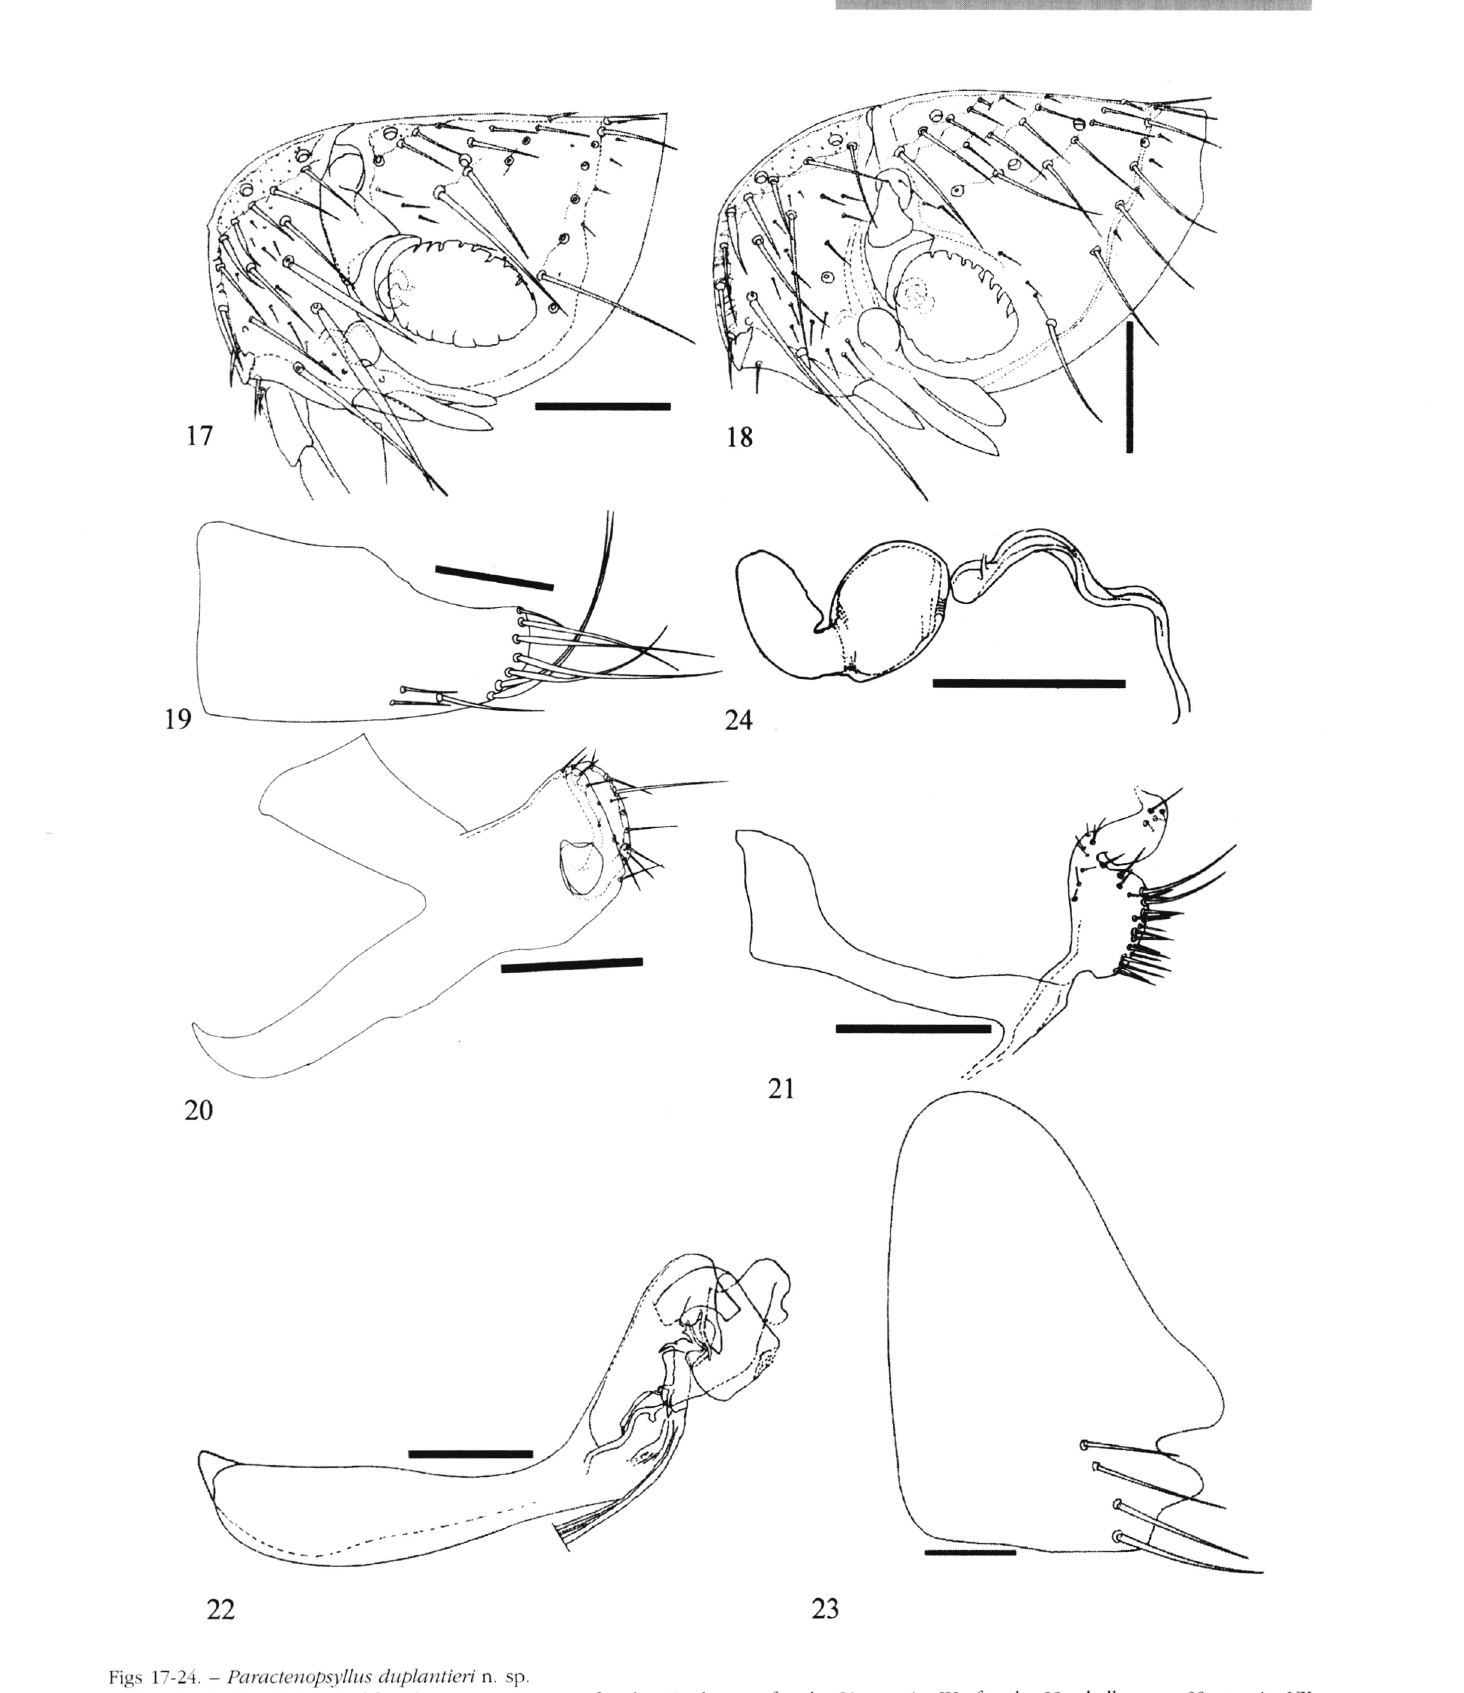
Figs 17-24. - Paractenopsyllus duplantieri n. sp. 17: head of male; 18: head of female; 19: sternite VIII of male; 20: clasper of male; 21: sternite IX of male; 22: phallosome; 23: sternite VII of female; 24: spermatheca and ductus bursae. All scale bars = 0,1